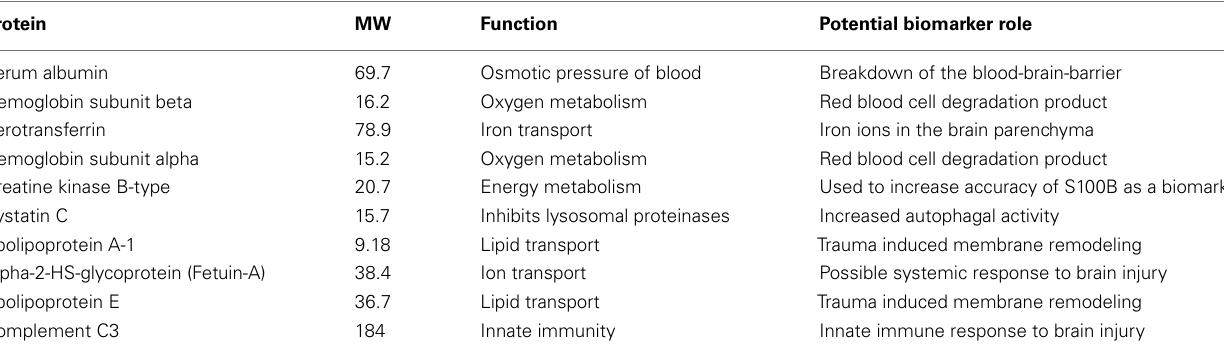
Table 1 | Functional properties of relevance for a potential future biomarker role for some of the proteins used to study MD catheter in vivo performance in our porcine brain injury model (16)